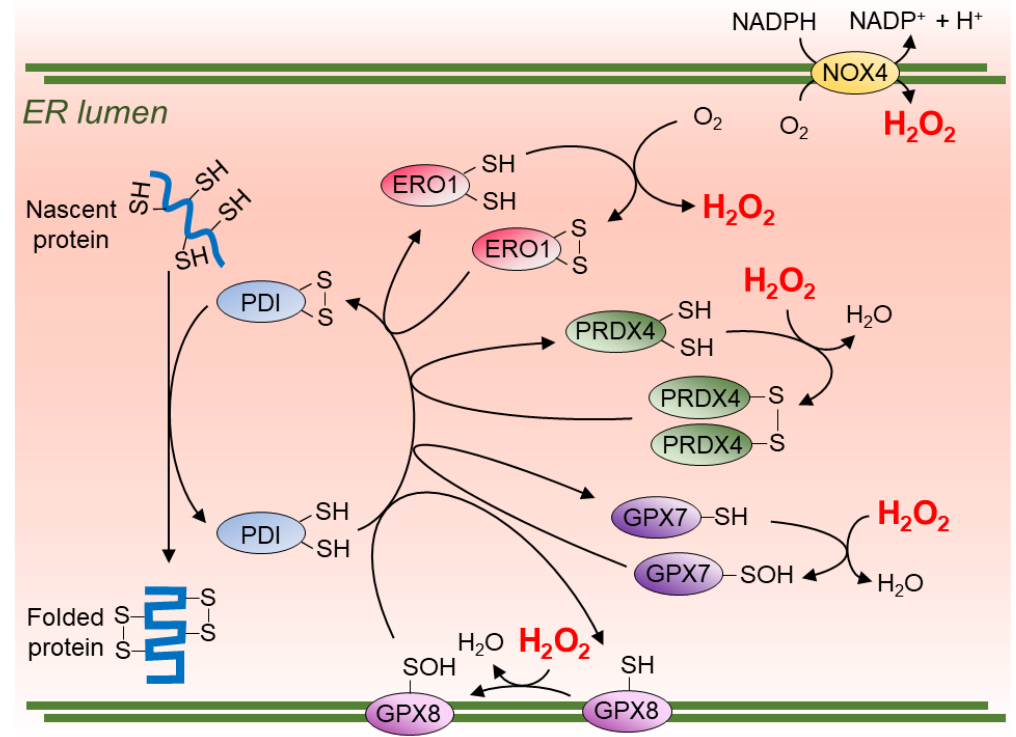
Figure 1. Schema of pathways producing and utilising endoplasmic reticulum (ER)-derived H 2 O 2 . Reduced thiols (-SH) of cysteine residues in nascent proteins are oxidised by catalytically competent protein disulphide isomerase (PDI)s to promote protein folding with native disulphide bonds (S-S). PDI can be re-oxidised by ERO1, with flavin adenine dinucleotide (FAD) embedded in its active site, which reduces molecular oxygen (O 2 ) to hydrogen peroxide (H 2 O 2 ). ER-resident antioxidants PRDX4, GPX7, and GPX8 oxidise their catalytic domain by utilising H 2 O 2 (-SOH = sulfenic acid) and mediate “the disulphide relay” to PDI. NOX4 produces H 2 O 2 over superoxide on the ER membrane, unlike other NOX family proteins.